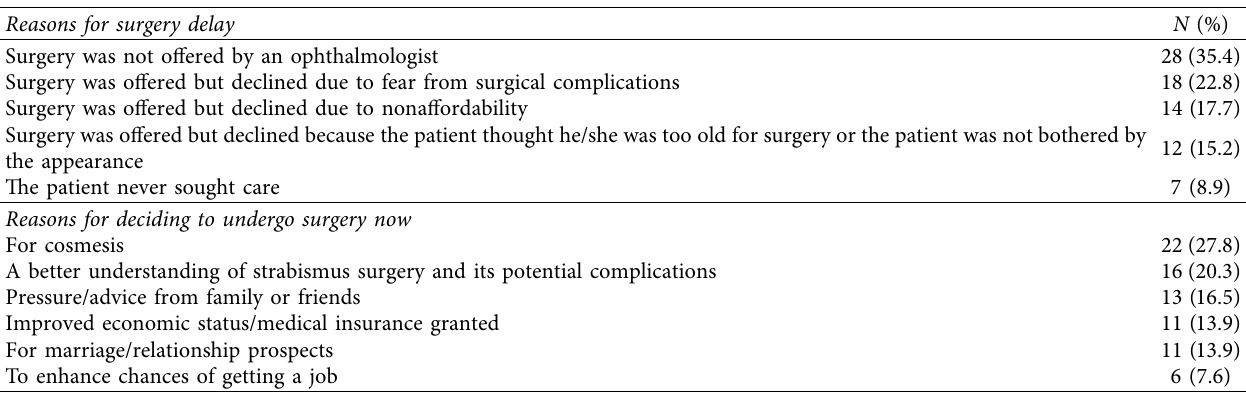
Table 2: Reasons for strabismus surgery delay and seeking treatment now (n � 79).